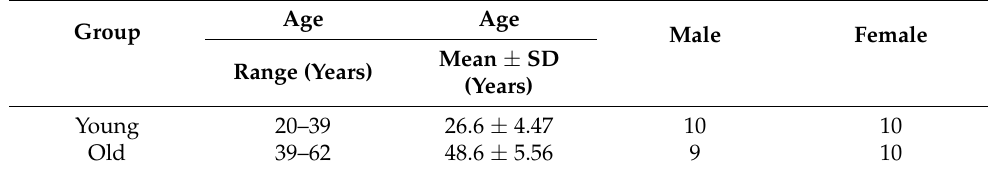
Table 3. Characteristics of the